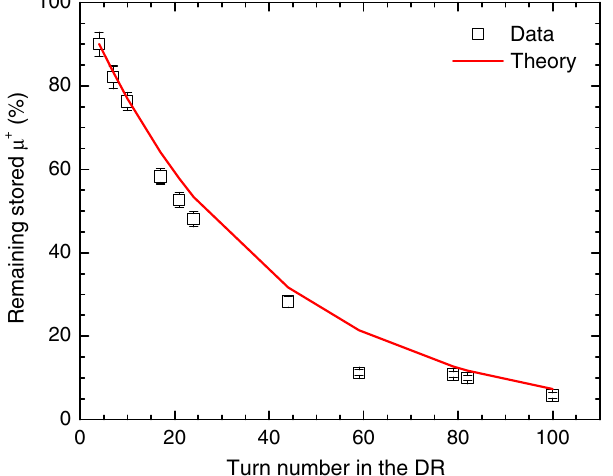
FIG. 11. Total beam intensity recorded at IC025, just upstream of the storage ring entrance of the Muon g − 2 experiment. After the fourth turn, the beam in the DR contains a mixture of muons, positrons, and deuterons. While muons and positrons have nearly the same revolution time along the DR, deuterons have not. However, for some turns (7, 21, and 82), they will catch up with the rest of the beam, and as a result the intensity increases. The solid curves illustrate the simulated rates of muons (green) and positrons (magenta) as a function of the turn